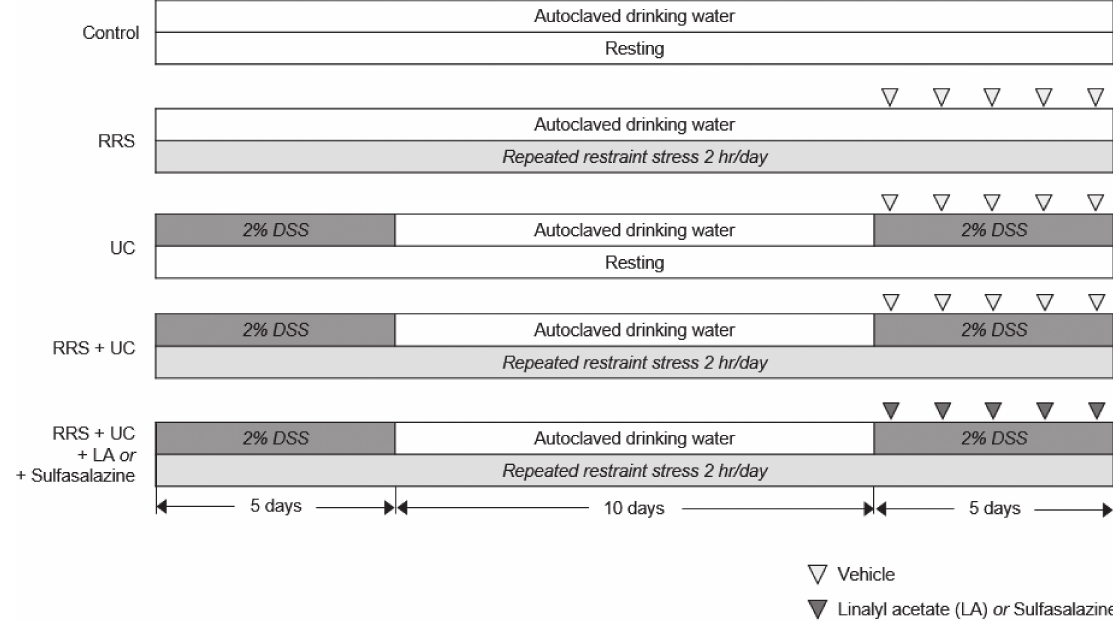
Fig. 1 Experimental design. DSS, dextran sodium sulfate; LA, linalyl acetate; RRS, restraint stress; UC, ulcerative